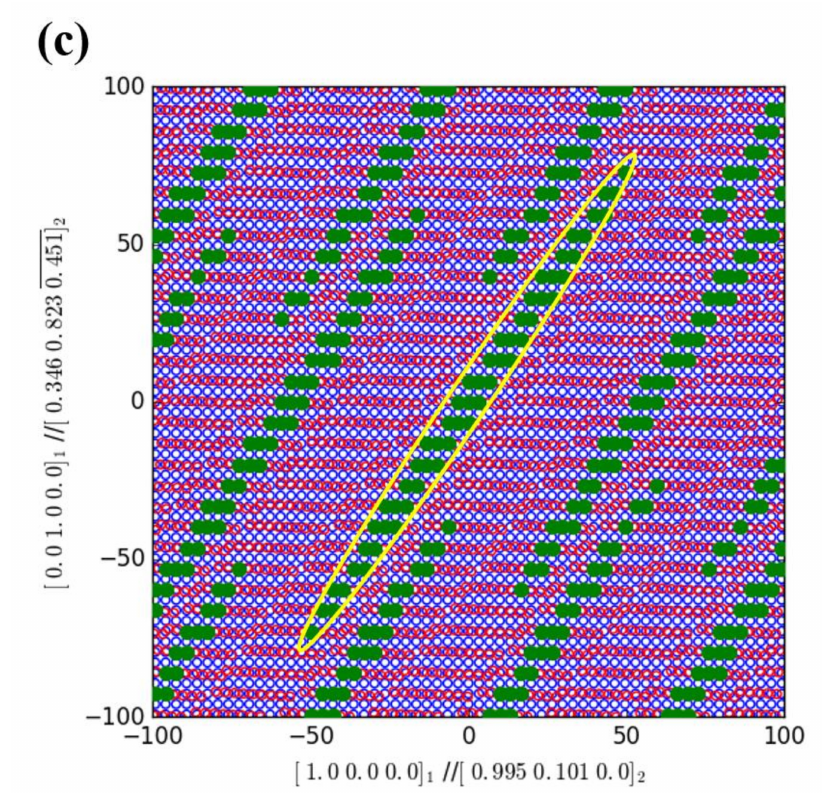
Figure 2. ( a ) Atomic arrangement and phase interface of the b.c.c. β and the h.c.p. α phase, ( b ) the atomic misfit of the (001) β (cid:107) (1120) α interface in the 0 ◦ lamellar structure, ( c ) the atomic misfit of the (001) β (cid:107) (1012) α interface in the 45 ◦ lamellar structure. Red open circles represent the atoms in b.c.c. β phase, blue open circles are for atoms in h.c.p. α structure. Solid green circles indicate the good matching sites within the interface, which are marked and surrounded by yellow